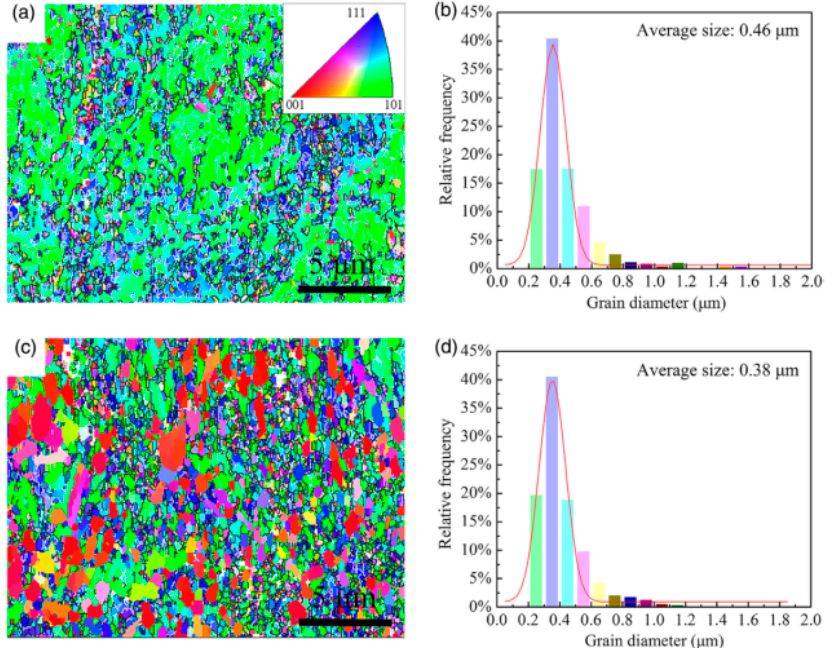
Figure 11. EBSD IPF maps and copper grain size distribution of as-cast (TiB 2p + TiB w )/Cu composites: ( a , b ) without rare-earth Ce; ( c , d ) with 0.04 wt.% Ce [35]. Reprinted/adapted with permission from Ref. [35]. Copyright year 2022, John Wiley and Sons.